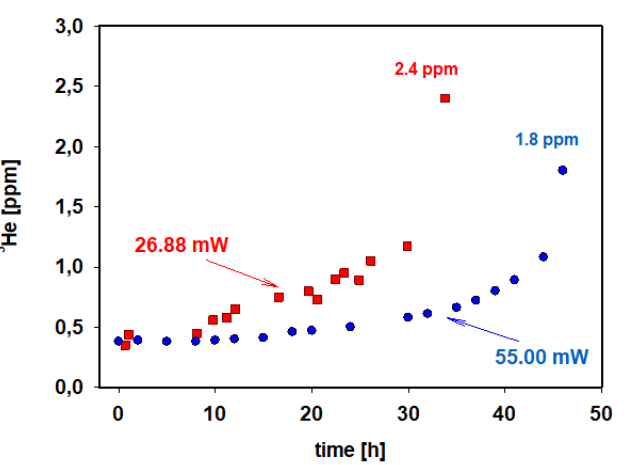
Figure 8. Concentration of 3 He in the 3 He- 4 He mixture vs time for two filtration processes—one with heater power of 26.88 mW (red squares) and one with 55.00 mW (blue circles). Entropy filter was composed of ZrO 2 /MWCNTs